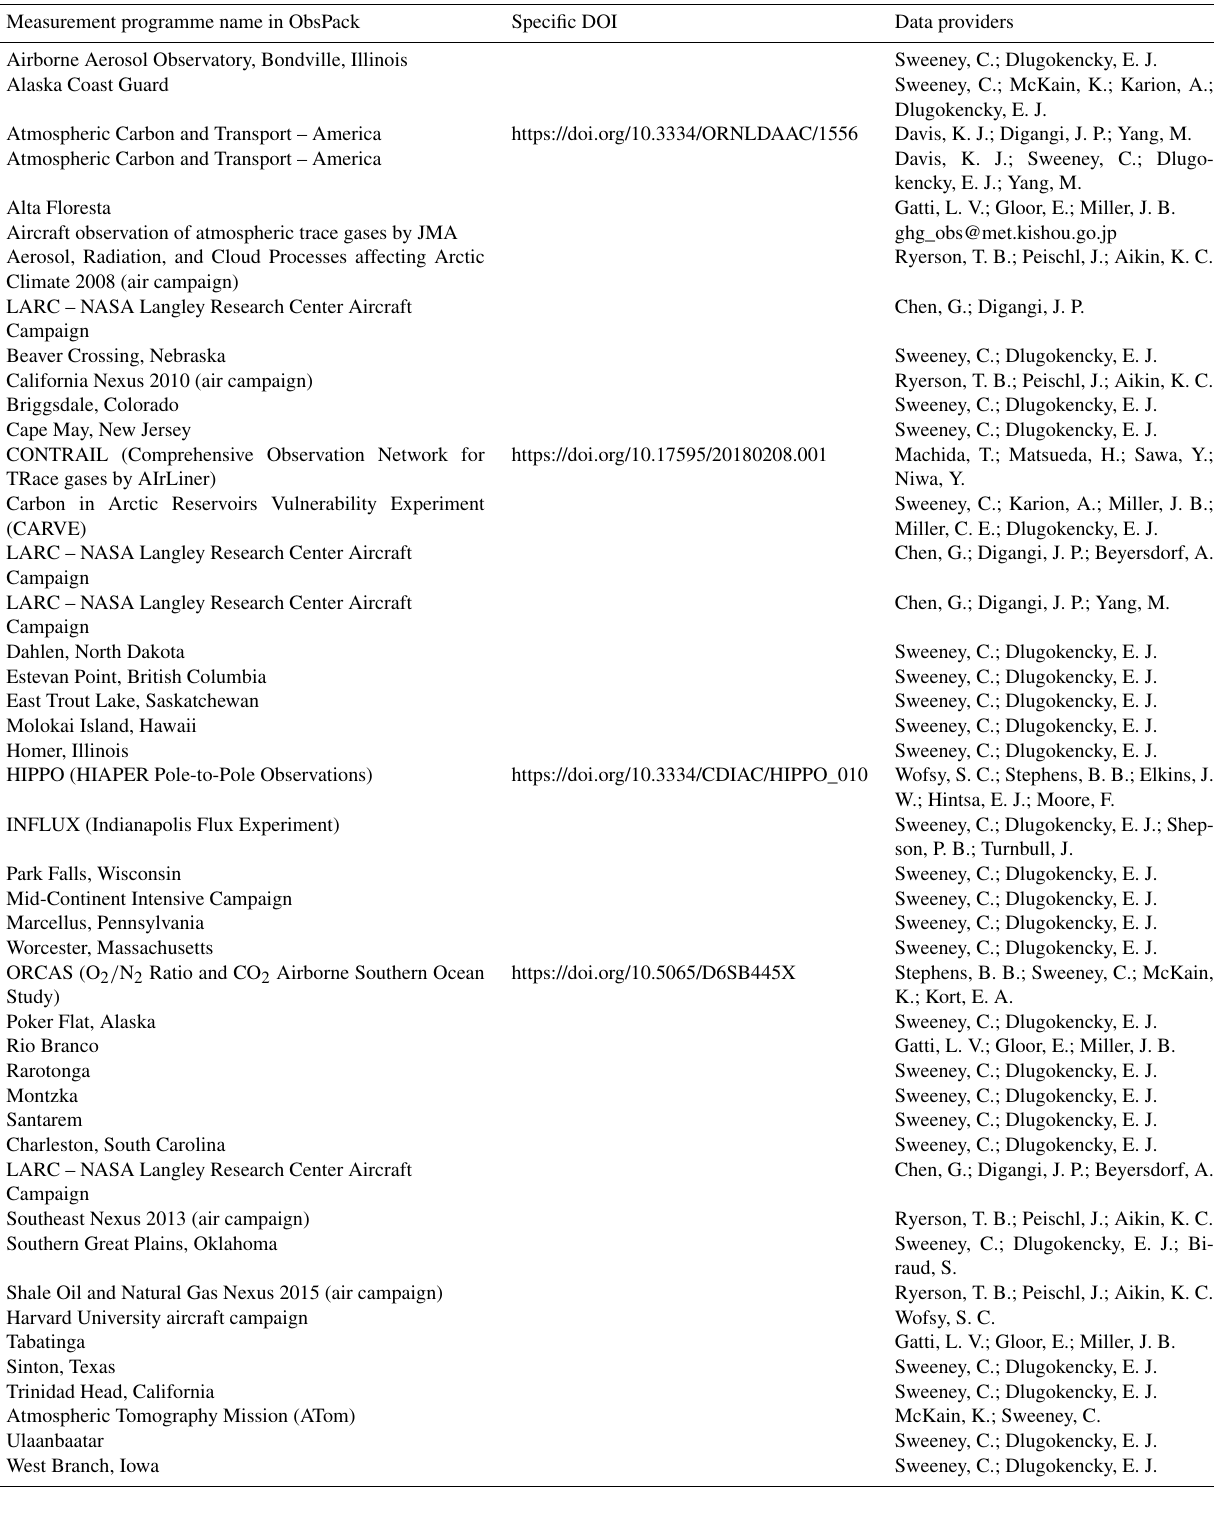
Table A6. Aircraft measurement programmes archived by Cooperative Global Atmospheric Data Integration Project (CGADIP, 2017) that contribute to the evaluation of the atmospheric inversions (Fig.